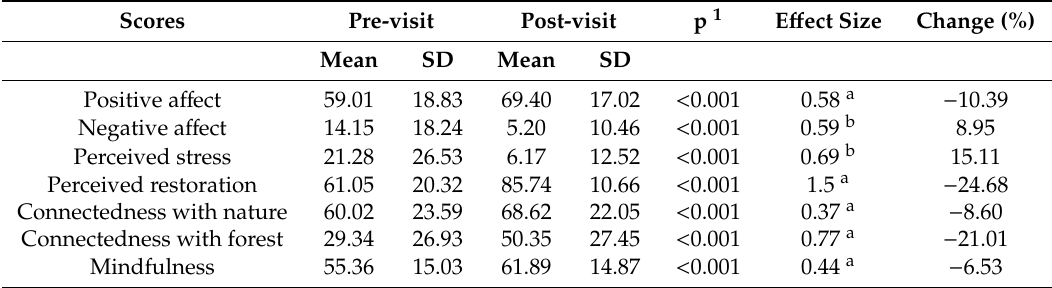
Table 2. Participants’ feelings and perceptions pre- and